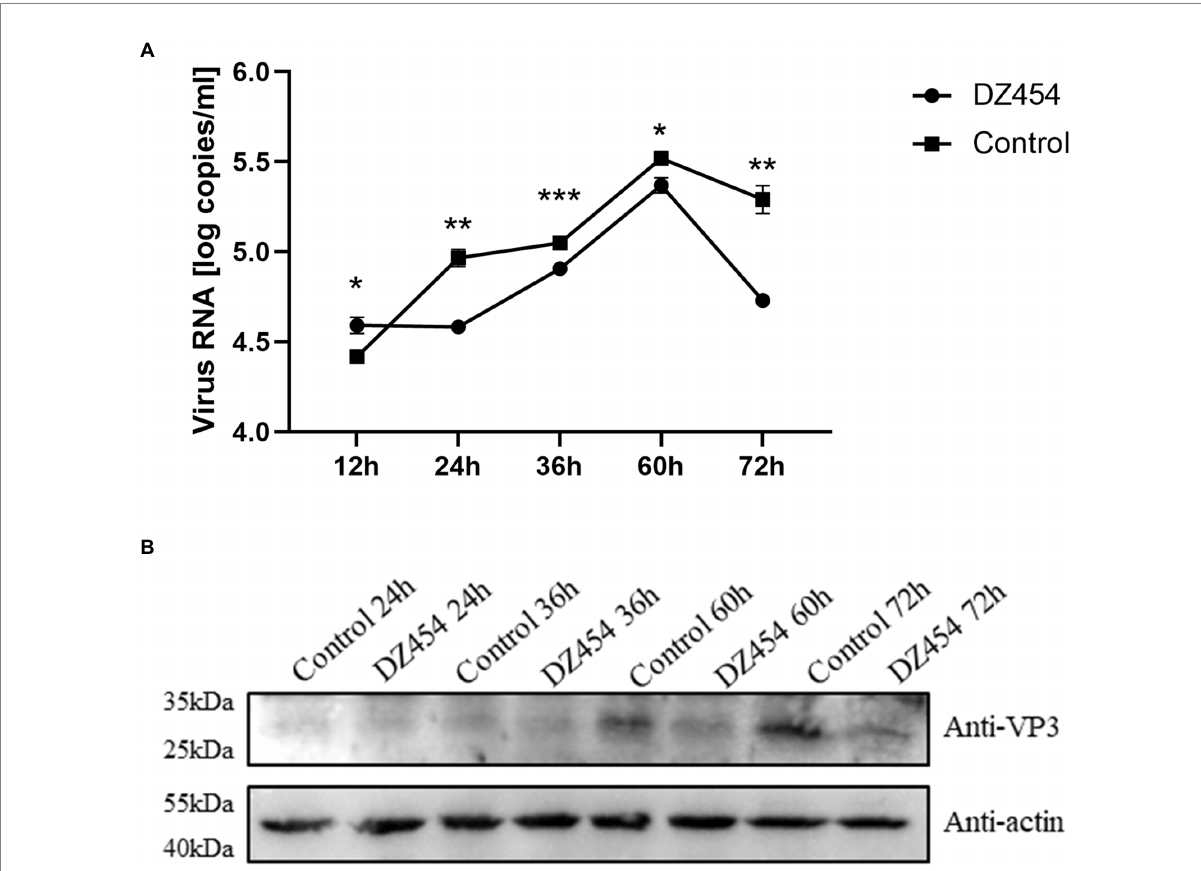
FIGURE 8 DZ454 inhibits the replication of DHAV-1. (A) DZ454 was transfected into DEFs, and the cells were infected with 100 TCID 50 of the DHAV-1 X strain. RT-qPCR was used to measure virus copy numbers after 12, 24, 36, 60, and 72 h. The difference between the DZ454 group and the control group was analyzed by Student’s t -test; * p < 0.05; ** p < 0.01; or *** p < 0.001. (B) The structural protein VP3 was detected in DEFs transfected with